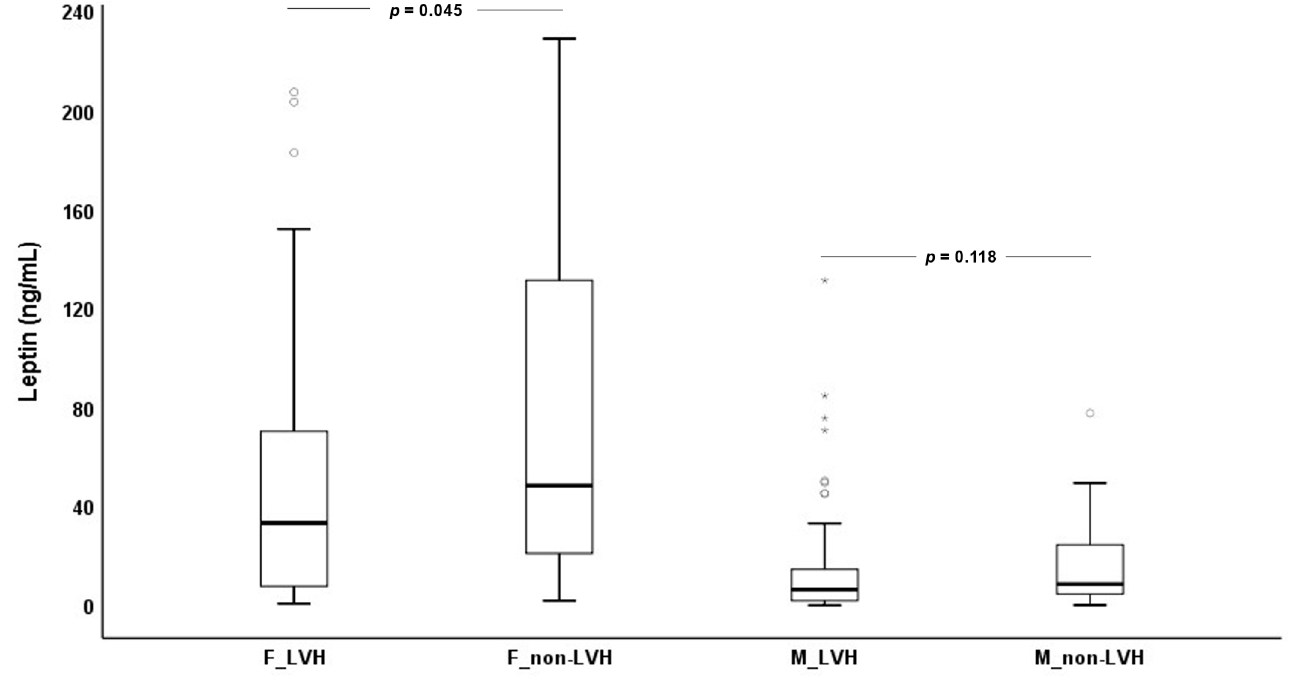
Figure 1. Leptin values for females (F) and males (M) with (LVH) and without left ventricular hypertrophy (non-LVH).